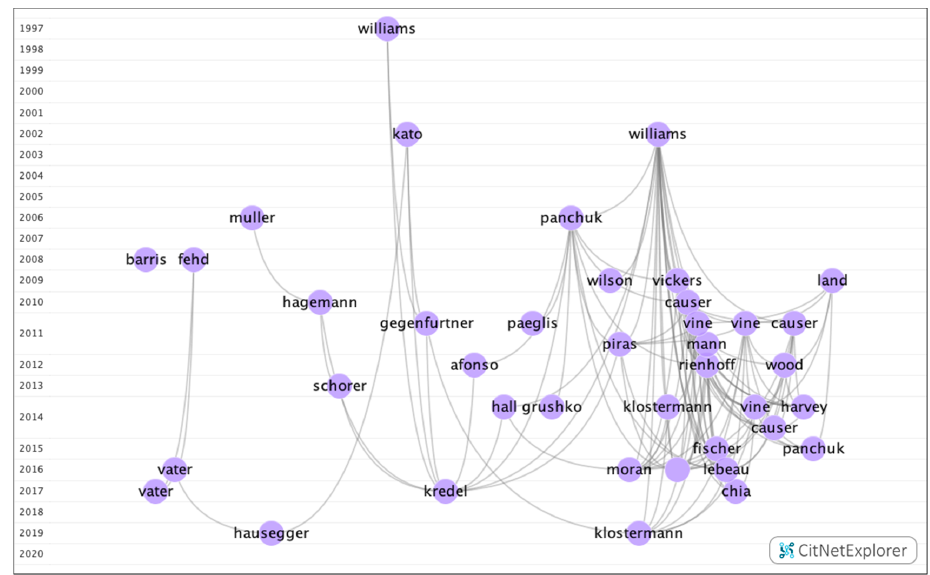
Figure 6. Citation network in group 3.